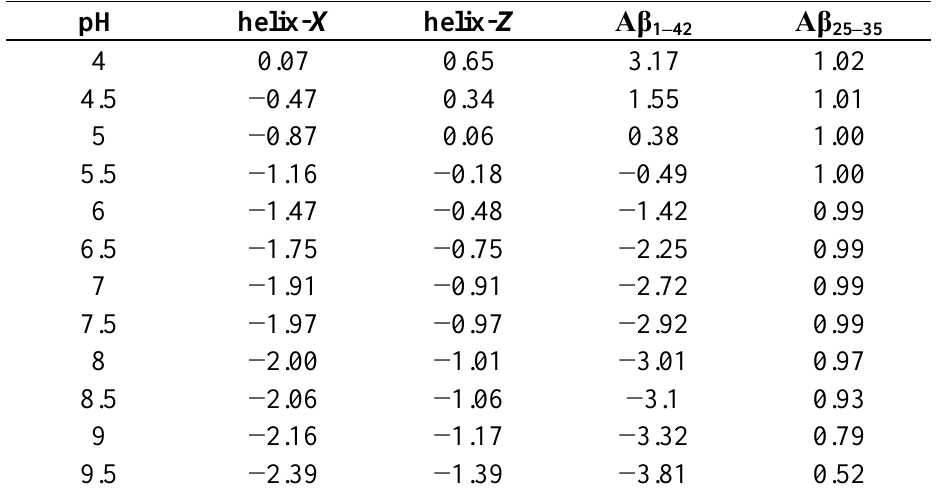
Table 2. Net charge distribution of peptides as a function of